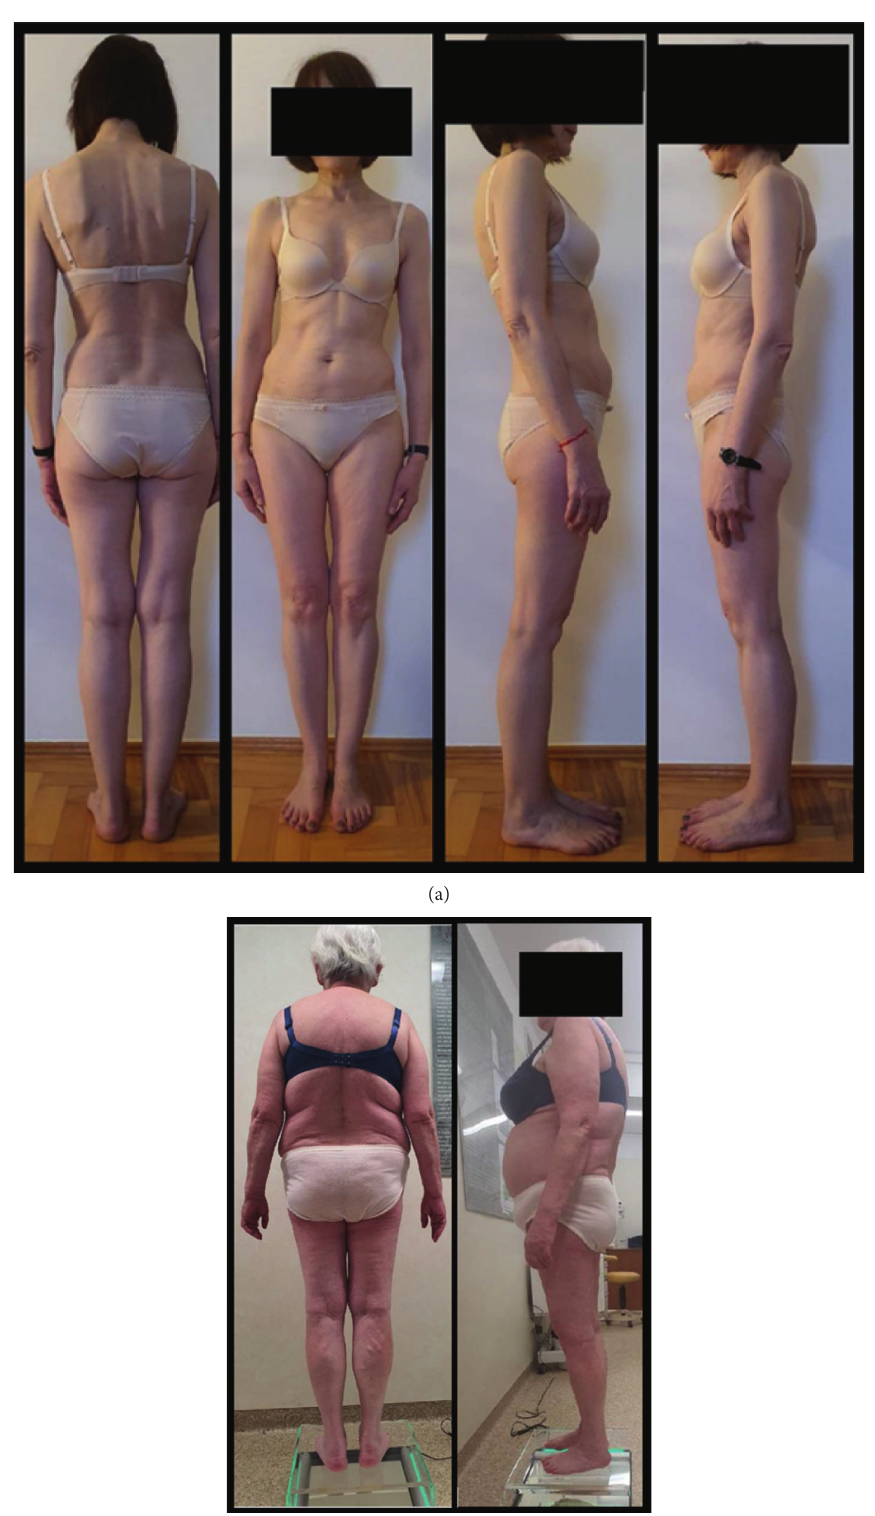
Figure 2: (a) A visual examination of an exemplary patient. (b) A visual examination of an exemplary